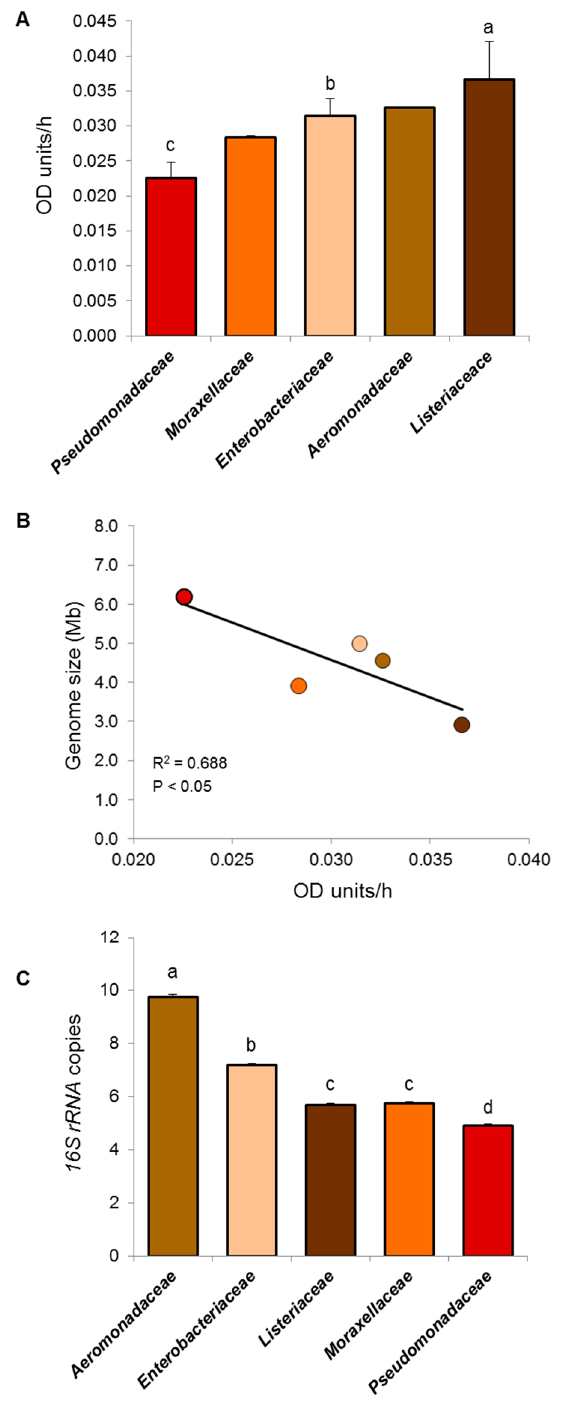
Figure 2. Growth phenotype and genotype of candidate Specific Spoilage Organism (SSO) obtained from spoiled chicken meat. ( A ) Maximum growth rates estimated with DMFit software and Baranyi and Roberts model. Two independent experiments were performed, each carried out in triplicate. Statistical assessment was performed only for bacterial families with > 3 isolates. ( B ) Pearson correlation coe ffi cient (R 2 ) between genome size and maximum growth rate. Circle color coding as in panels A and C. OD: optical density. ( C ) 16S rRNA copy number. Graphs depict mean values and its standard errors. Di ff erent letters are significantly di ff erent ( p < 0.05). Statistical analysis was performed by means of ANOVA Fisher’s protected least significant di ff erence